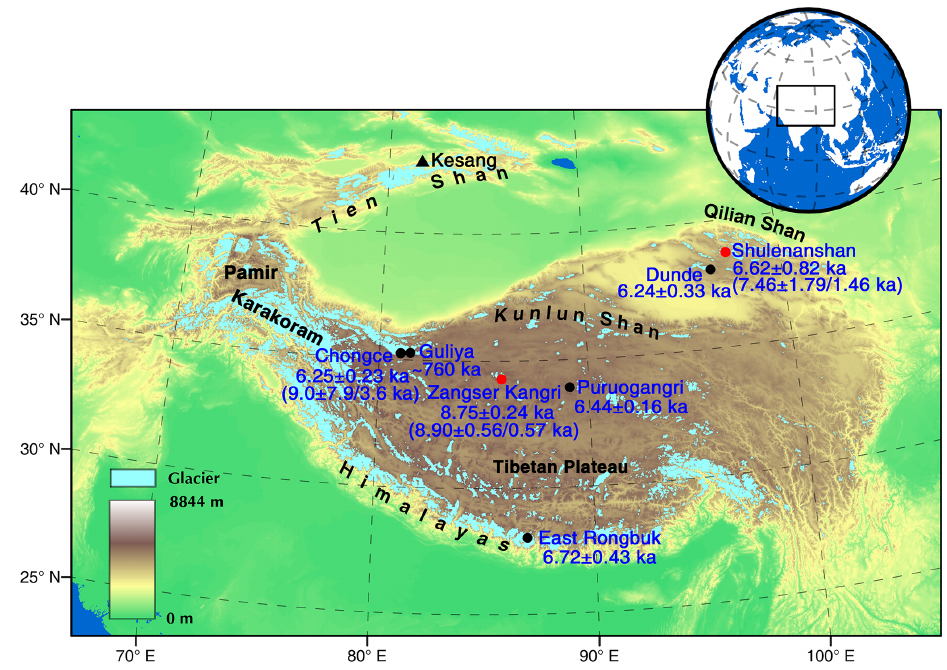
Figure 1. Map showing the locations of ice core drilling sites. The numbers for each site except Guliya are the oldest measured 14 C ages, while the number inside the brackets is the estimated ice age at the ice–bedrock contact. Data of glaciers are from the Global Land Ice Measurements from Space (GLIMS; available at http://www.glims.org, last access: 4 August 2020). The topographic data were extracted from ETOPO1 elevation global data, available from National Oceanic and Atmospheric Administration at http://www.ngdc.noaa.gov/mgg/ global/global.html (last access: 4 August